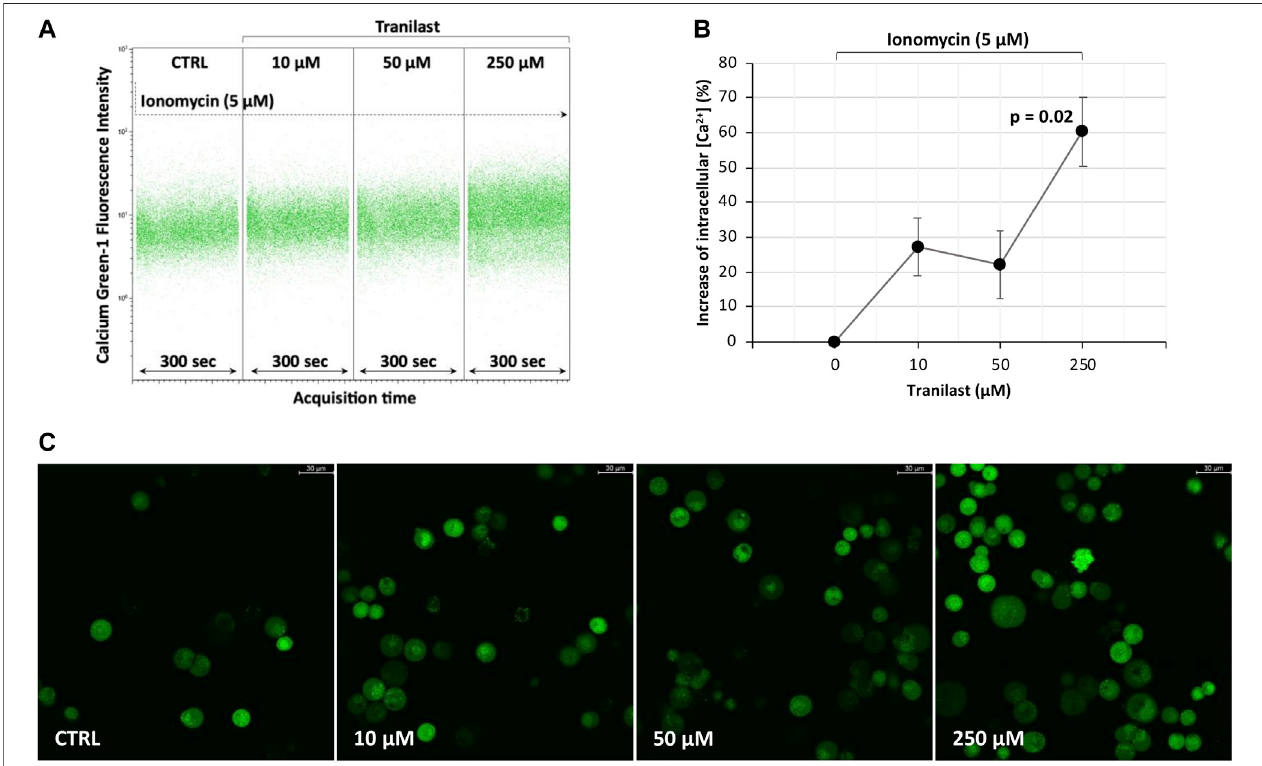
FIGURE 3 | Effect of TRPV2 chemical inhibition on intracellular calcium levels. (A) Representative fl ow cytometry dot plots of calcium green-1-AM staining to measure intracellular calcium levels. (B) Estimation of mean fl uorescence intensity differences measured by fl ow cytometry among the tranilast-treated groups and control. t -test was used to perform multiple comparisons on three replicates. (C) Fluorescence microscopy evaluation of intracellular calcium levels in the presence of ionomycin (5 µM) and different concentrations of TRPV2 inhibitor ( × 20 magni fi cation, Leica SP8